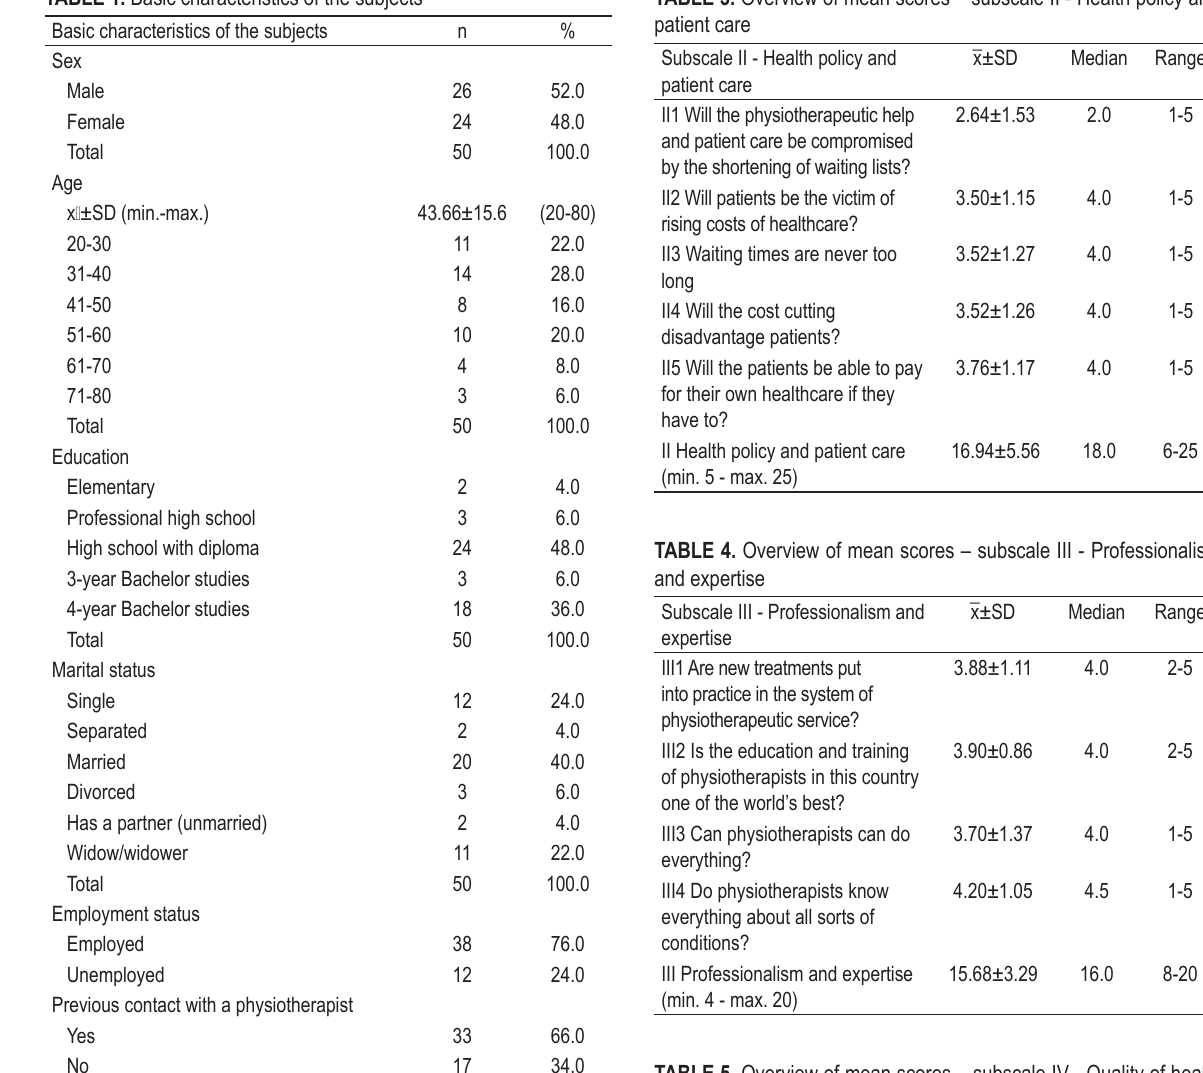
TABLE 5. Overview of mean scores – subscale IV - Quality of